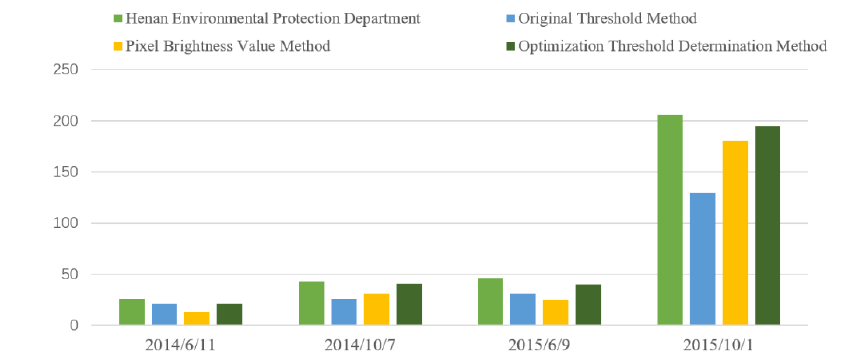
Figure 5 . Statistics of the number of fire spots correctly recognized on June11,2014, October 7, 2014, June 9, 2015 and October 1,